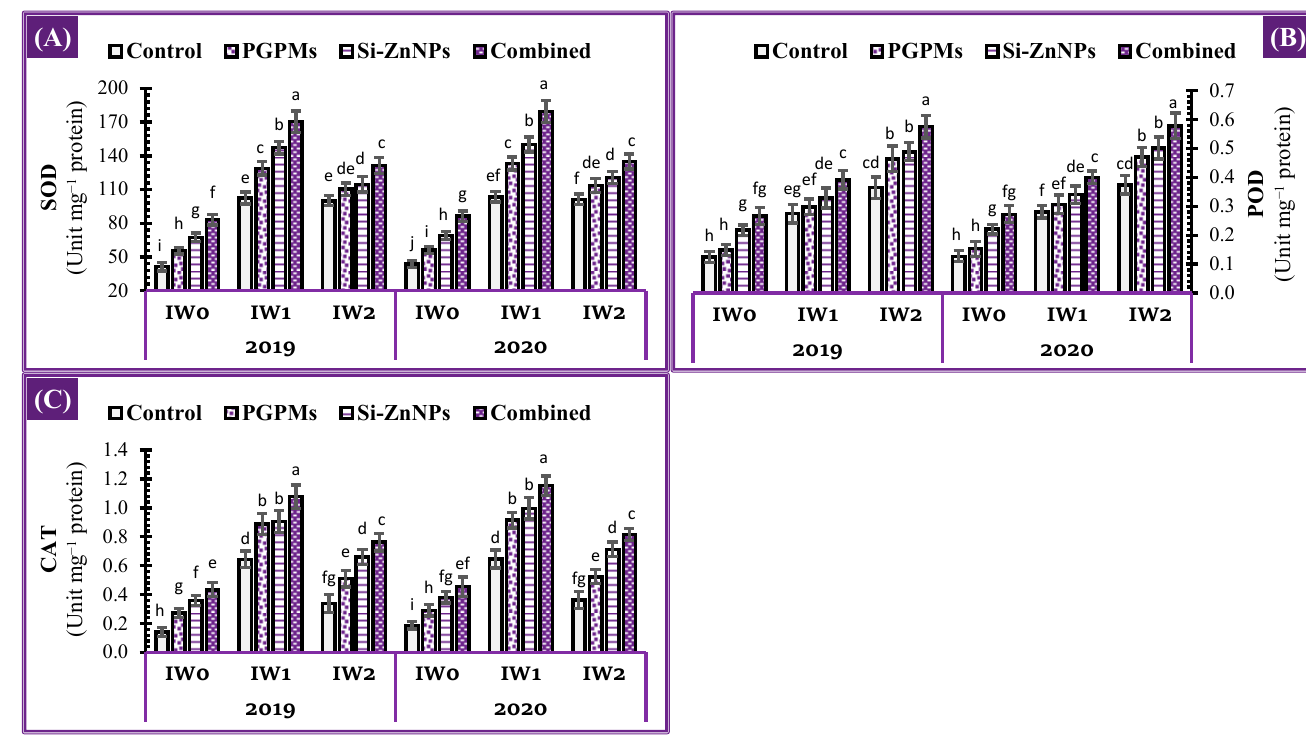
Figure 5. Influence of application of PGPMs, Si-ZnNPs and their combination on the activity of antioxidant enzymes, i.e., ( A ) SOD, ( B ) POD, and ( C ) CAT in the leaves of soybean plant grown in salt-affected soil with different levels of watering intervals ( IW 0 ; 11 days, IW 1 ; 15 days, and IW 2 ; 19 days) during the successive 2019 and 2020 growing seasons. The data presented as means ± SD. Means labeled with the same lower-case letter are not significantly different according to Duncan’s Multiple Range Test.